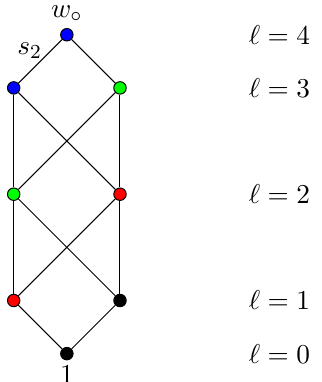
Figure 2 . The Bruhat order for the Weyl group of B 2 , and the length function. The longest element w (cid:14) has length four. There are two elements of length three. The lines at 45 (cid:14) correspond to the s 2 re(cid:13)ection, and we use the same color for elements of W connected by this re(cid:13)ection: they contribute to the same module M c , see equation